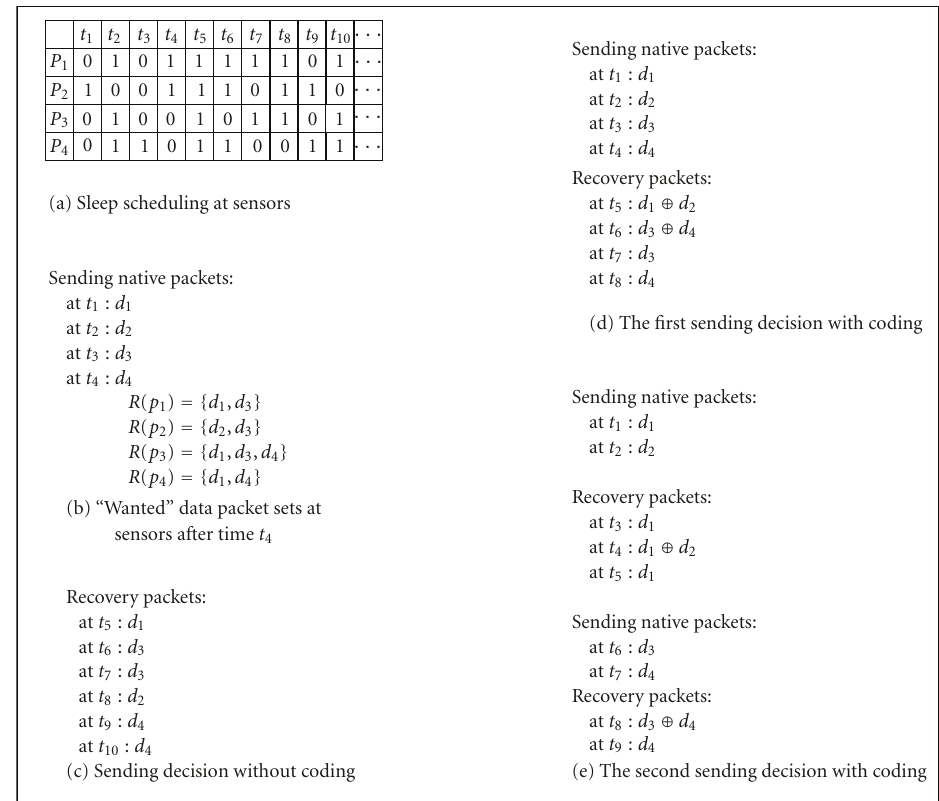
Figure 2: Comparison with di ff erent dissemination